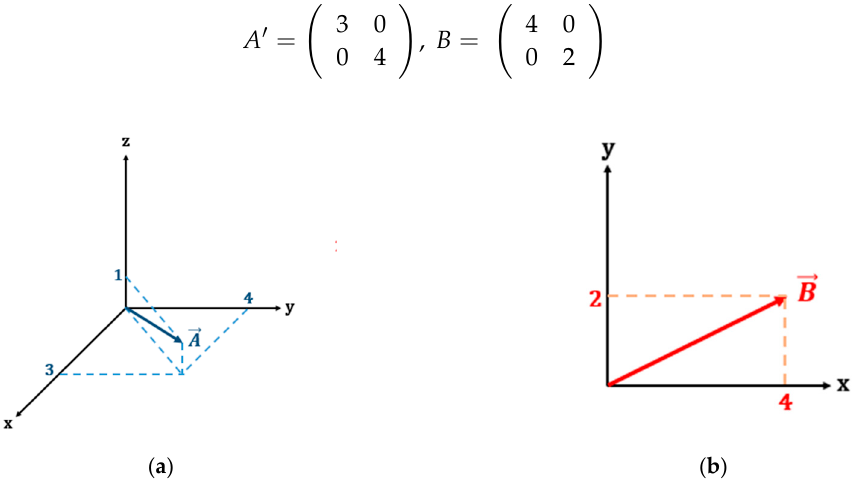
Figure 3. Vector of ( a ) diagonal A, and ( b ) diagonal B.